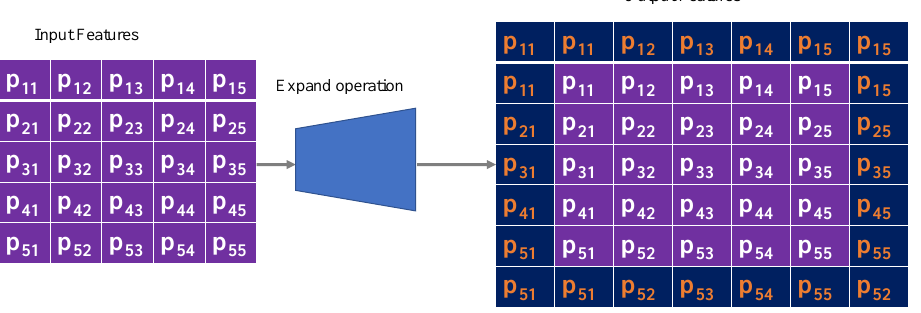
Figure 7. Demonstration of expanding layer operation (pad nearest neighbors from the original input filter the outside